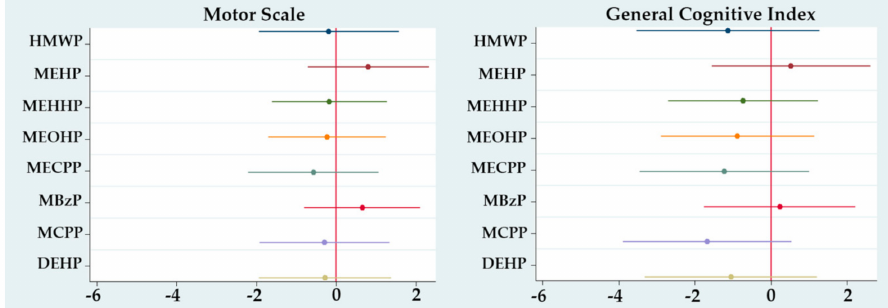
Figure 3. Regression coe ffi cients for change in McCarthy Scales of Children’s Abilities (MSCA) associated with a third trimester ln-unit increase in urinary phthalate metabolite concentration, adjusted for sex, gestational age, breastfeeding and maternal IQ. *Motor Scale: all metabolites p > 0.05; General Cognitive Index: all metabolites p >